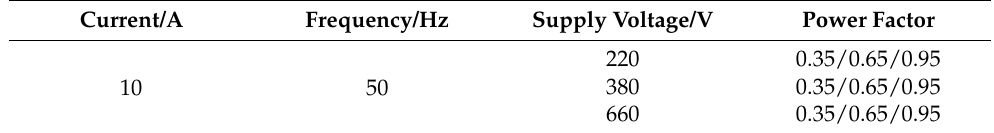
Table 1. Electrical life simulation test parameters.